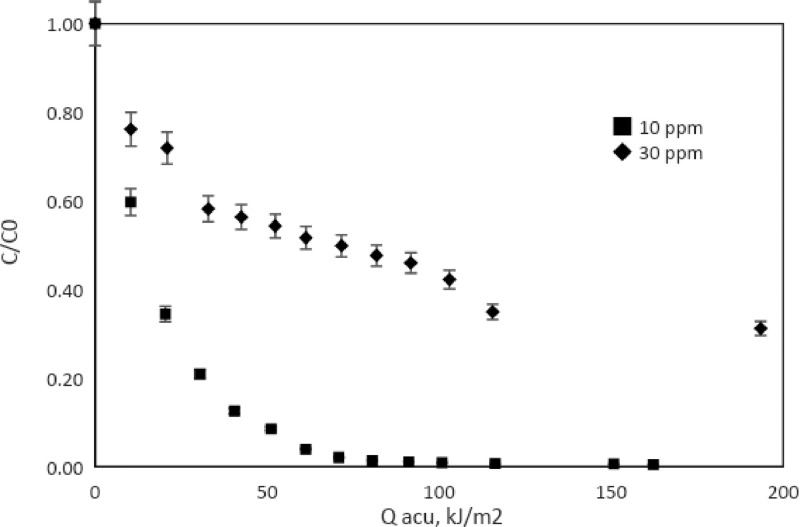
Degradation of AM vs UV energy accumulated. 0.3 g/L of TiO2/Fe3O4(80/20).